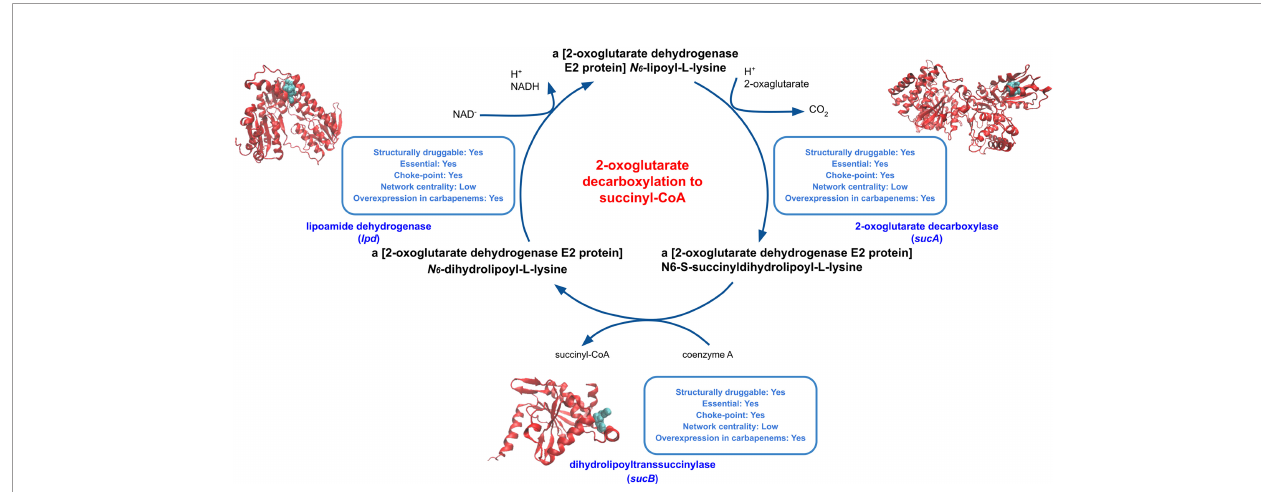
FIGURE 3 | Druggable features of the 2-oxoglutarate decarboxylation to succinyl-CoA pathway. The modeled structures of enzymes in the pathway are shown in red, with the predicted binding sites in cyan. The boxes next to each structure shows characteristics of these enzymes, such as druggability, essentiality, centrality in the reaction graph, and whether it is found overexpressed during carbapenem